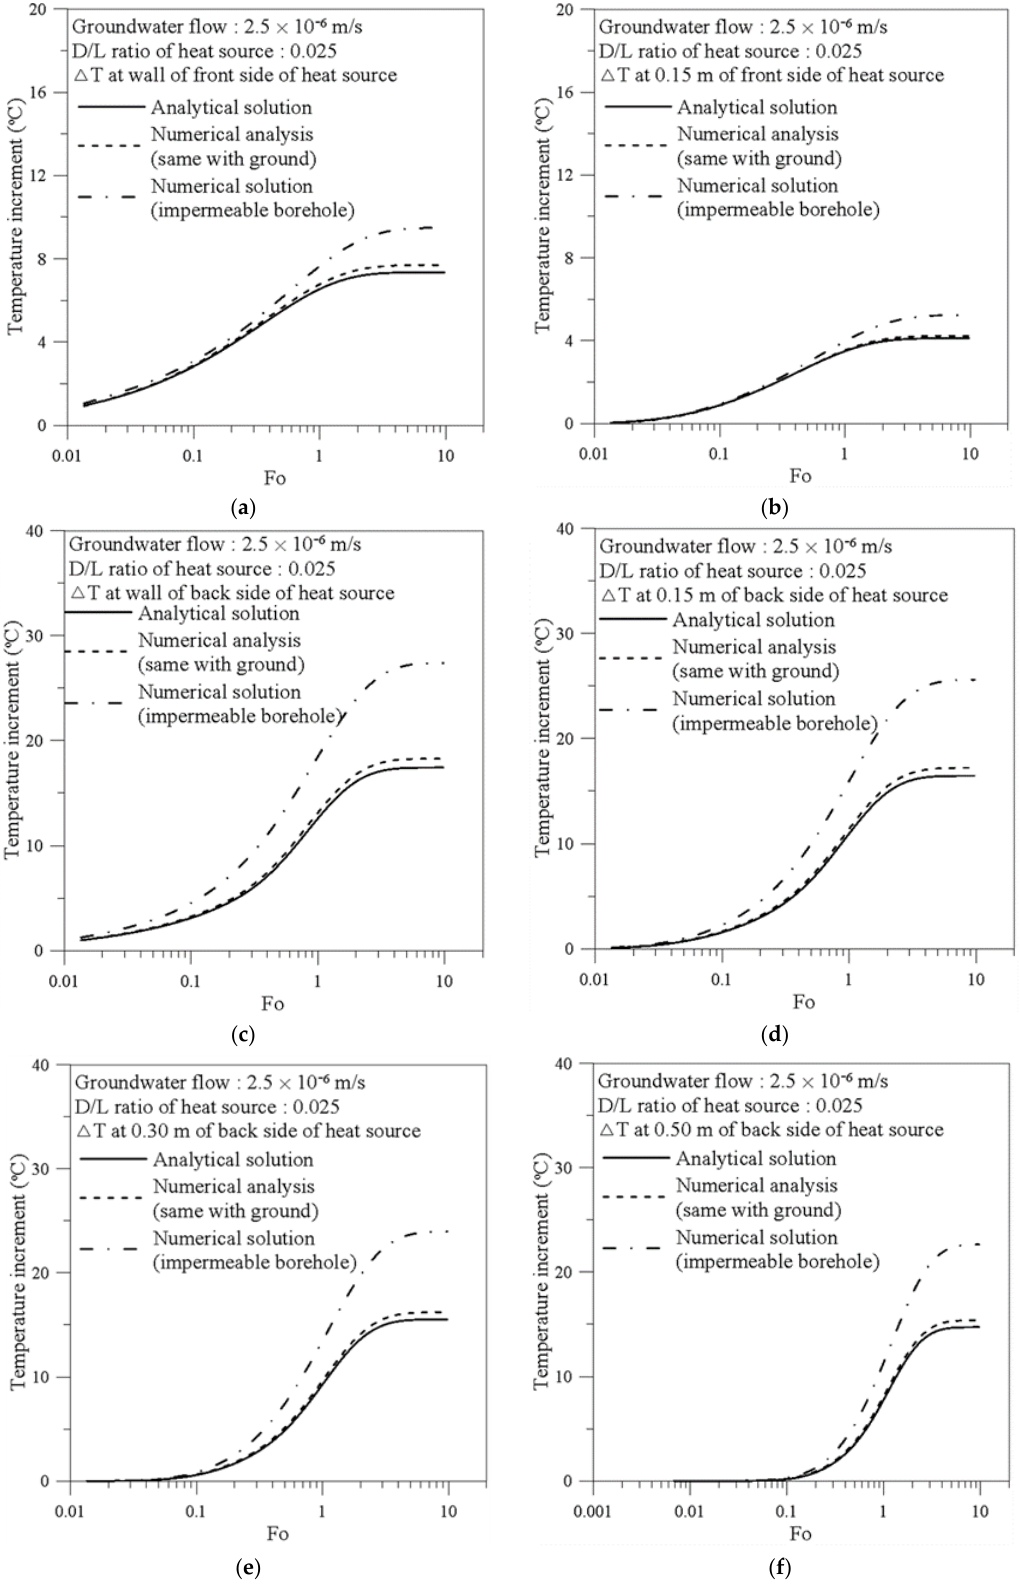
Figure 9. Comparison of analytical solution and numerical analysis results (u = 2.5 × 10 −6 m/s, D/L ratio = 0.025). Temperature increment at ( a ) wall of front side; ( b ) 0.15 m of front side; ( c ) wall of back side; ( d ) 0.15 m of back side; ( e ) 0.30 m of back side; ( f ) 0.50 m of back side.